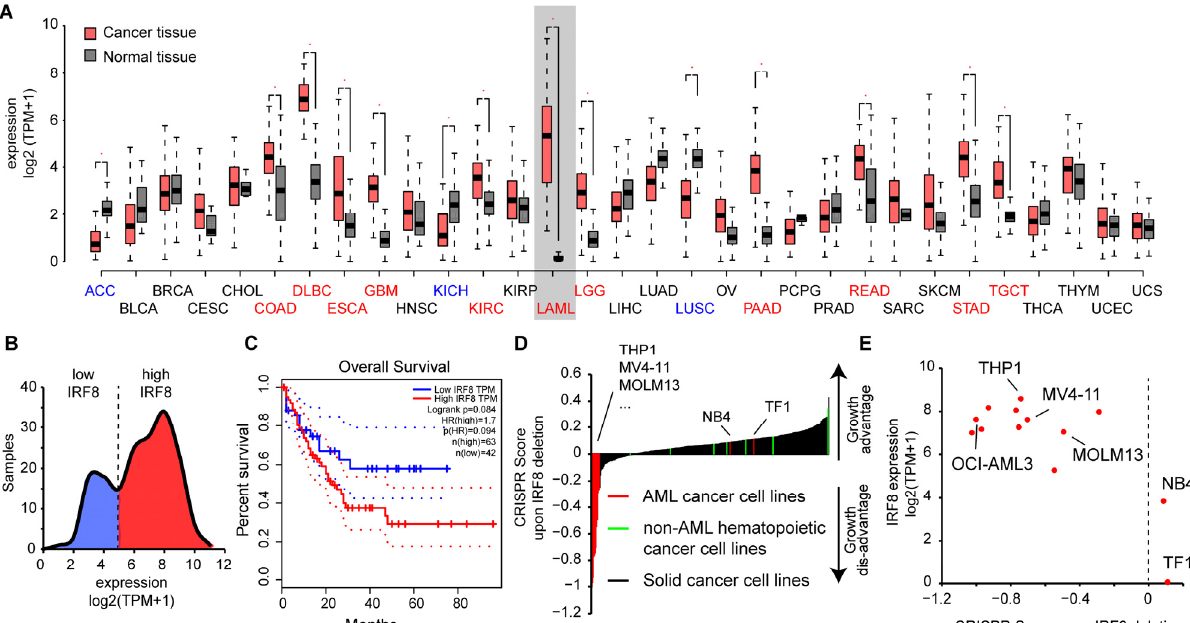
Figure 2. IRF8 is upregulated in AML and is associated with poor survival. ( A ) Gene expression of IRF8 in normal tissues (grey) and tumor samples (red). For LAML (Acute Myeloid Leukemia), samples from chronic myeloid leukemia (CML) cells are used as reference. Blue and red colored cancer names indicate significantly down- or upregulated IRF8 expression in those cancer types, respectively. Data from GEPIA [46]. ( B ) Distribution of IRF8 expression in TCGA AML cancer samples ( n = 173). ( C ) Kaplan–Meier survival curve comparing AML patients with low (blue) and high (red) IRF8 expression. Data from GEPIA [46]. ( D ) CRISPR score in 350 human cancer cell lines. IRF8 deletion in most AML cell lines (in red) leads to a negative CRISPR score, demonstrating reduced proliferation after IRF8 deletion. Non-AML hematopoietic cancer cell lines (green) are shown in comparison. ( E ) Association between IRF8 expression and CRISPR score in human AML cell lines. See Table S3, for details about the cell lines.